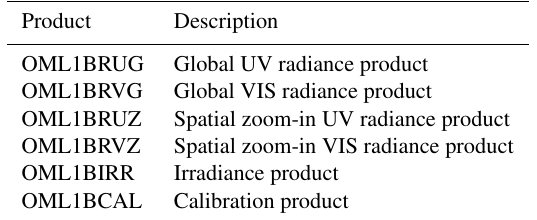
Table 2. Standard OMI Level 1 data